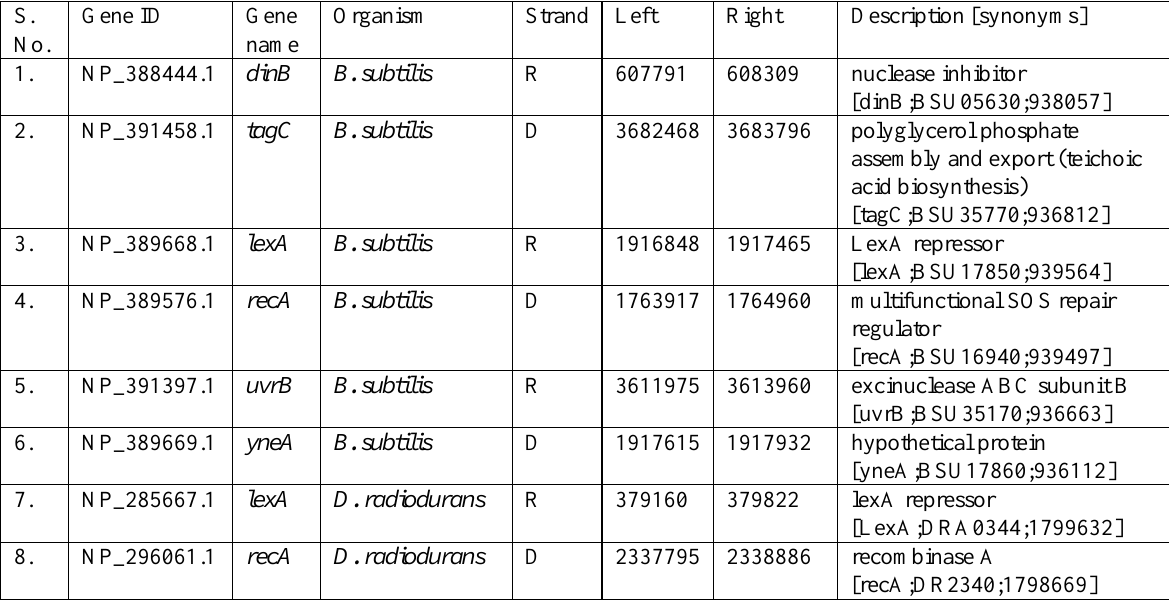
Supplementary Table 1 (S1): Details of example data set genes used for construction of improved SOS-box weight matrix.